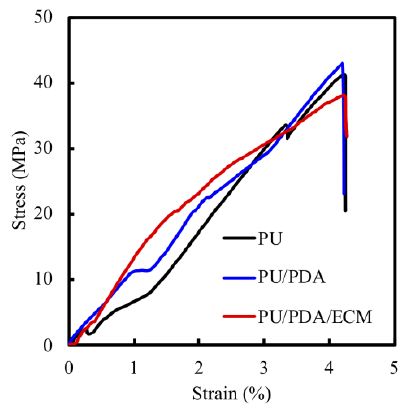
Figure 3. The tensile stress-strain curve of 3D-printed PU-based specimens.